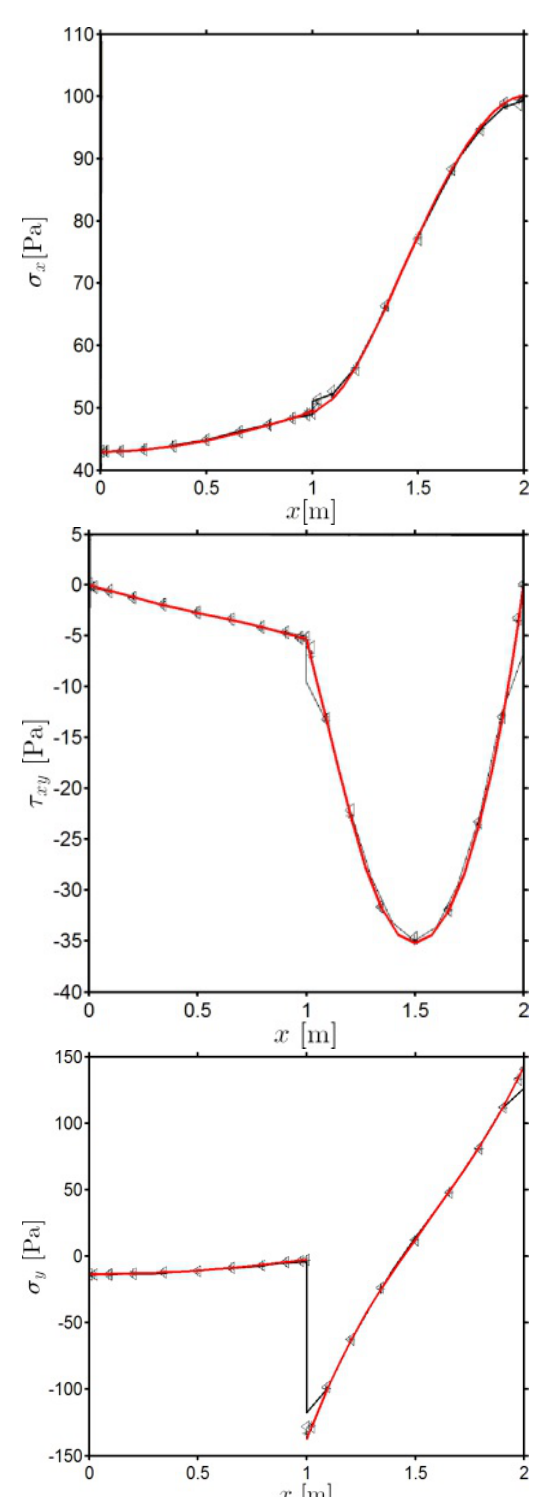
Figure 13: The present result using N = M = 21 for each element is compared to the same presented by Zong and Zhang [122], who solved the problem using multi-domain DQ and FEM (Abaqus).